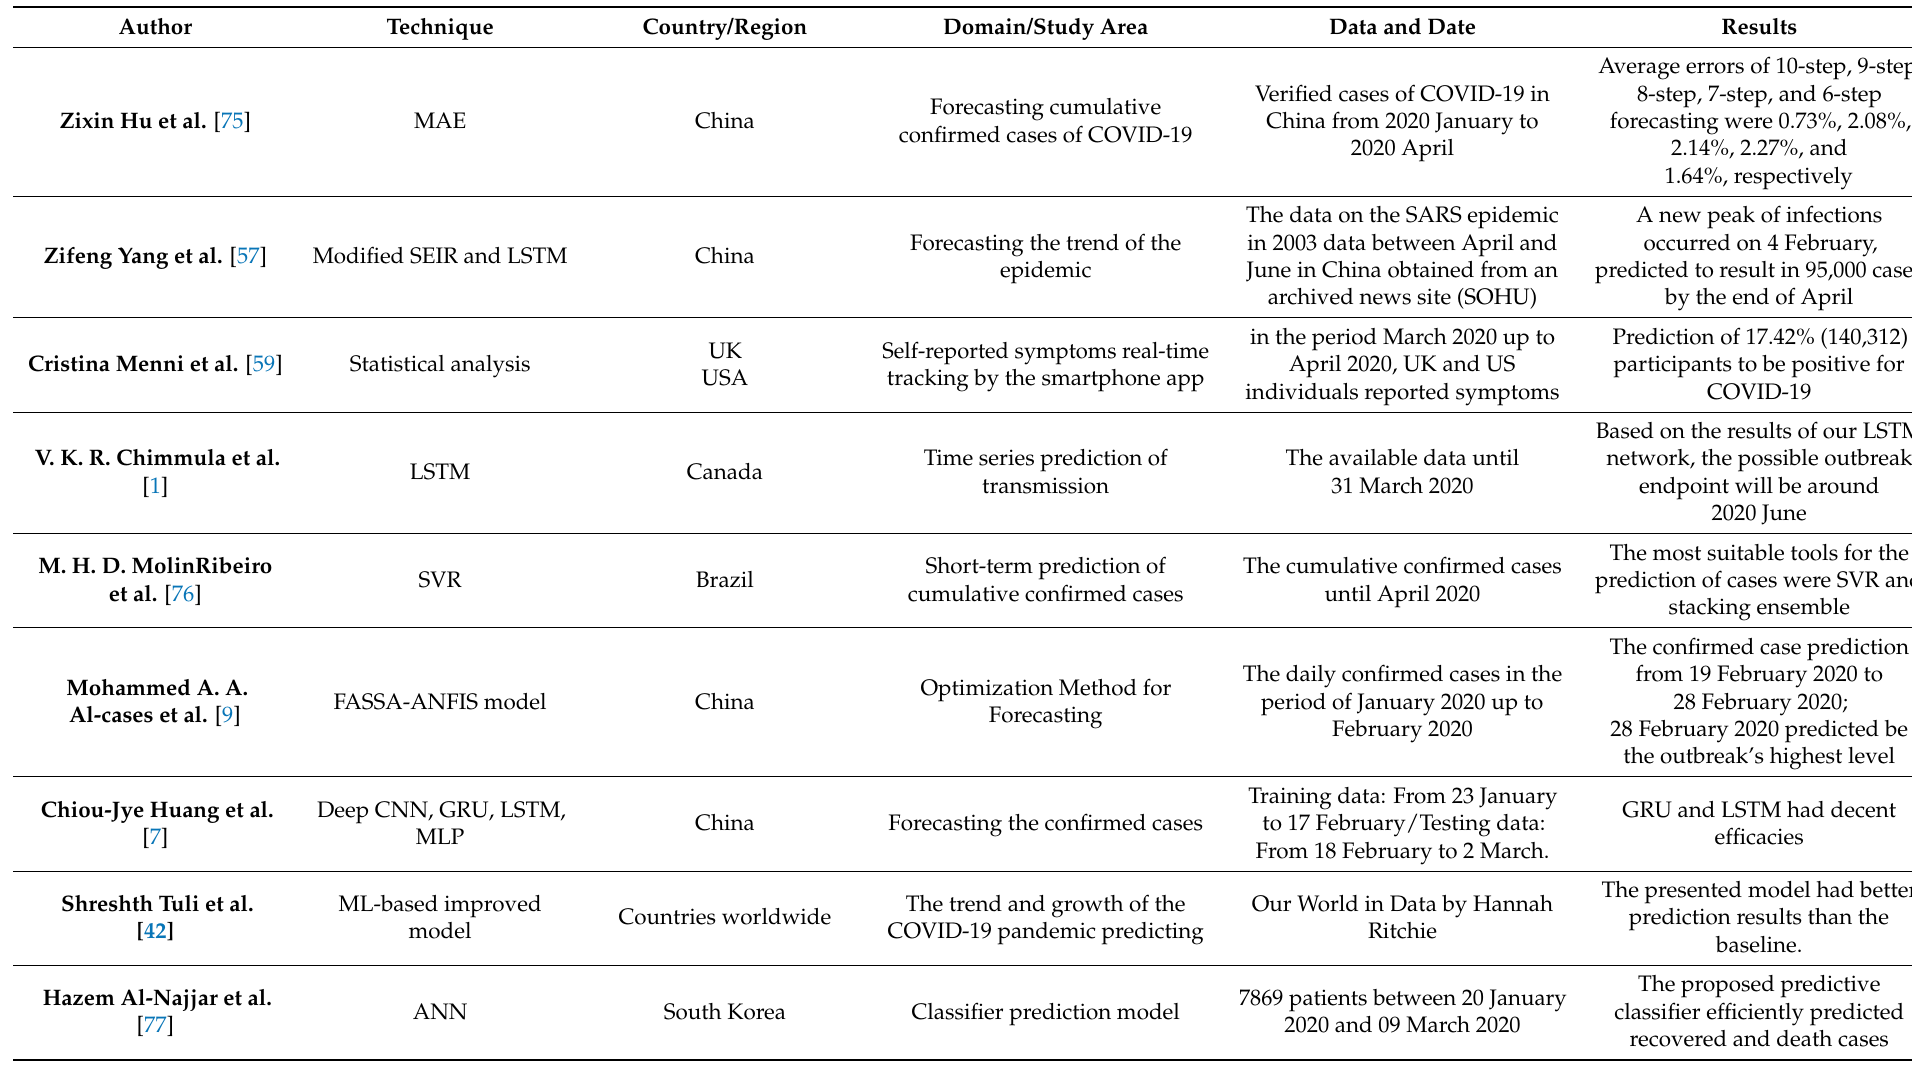
Table 1. ML and DL techniques used for the prediction of COVID-19 spread independently. These papers and documents were published in